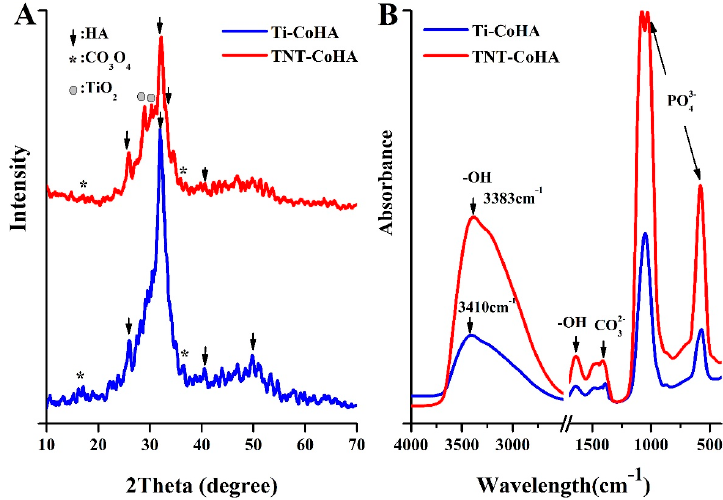
Figure 4. The crystal structure and chemical composition of Ti-CoHA and TNT-CoHA: ( A ) XRD patterns, ( B ) FTIR spectra.